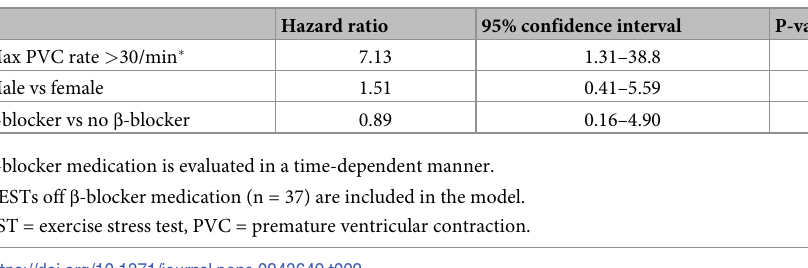
Table 2. Time-dependent Cox regression model: Risk factors of cardiac